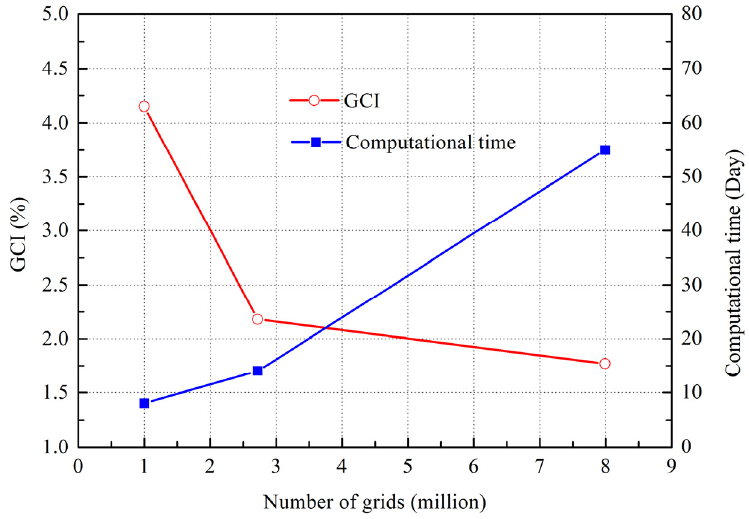
Figure 8. Comparison between computational time and GCI.